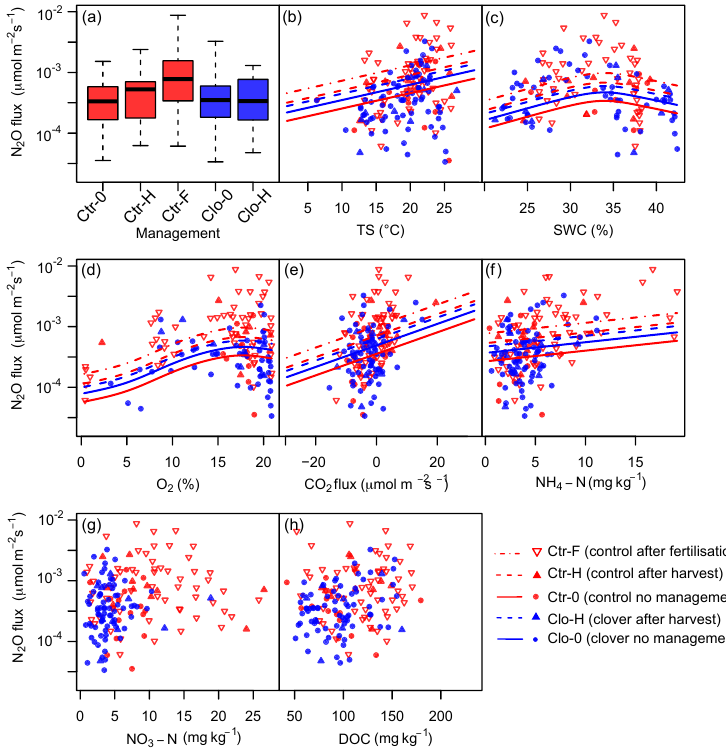
Figure 8. Influence of management and environmental variables on N 2 O emissions as predicted by the generalised additive model (GAM). Significant effects were found for (a) management, (b) soil temperature (TS, 0.1m of depth), (c) soil water content (SWC, 0.1m of depth), (d) oxygen concentration (O 2 , 0.1m of depth), and (e) carbon dioxide (CO 2 ) flux; while not significant, (f) ammonium-N concentration (NH 4 -N, 0–0.2m of depth) still improved the model (lowered the AIC). No significant influence was found for (g) nitrate-N concentration (NO 3 -N, 0–0.2m of depth) and (h) dissolved organic carbon concentration (DOC, 0–0.2m of depth). Measurements are displayed as squares for “no management”, with upward triangles for harvests at the control (red) and clover (blue) parcels and downward triangles (red) for fertilisation (control). Predictions are displayed if lowering AIC as solid lines for the category “no management”, as dashed lines for harvests, and as dot-dashed lines for fertilisation based on average values for all other